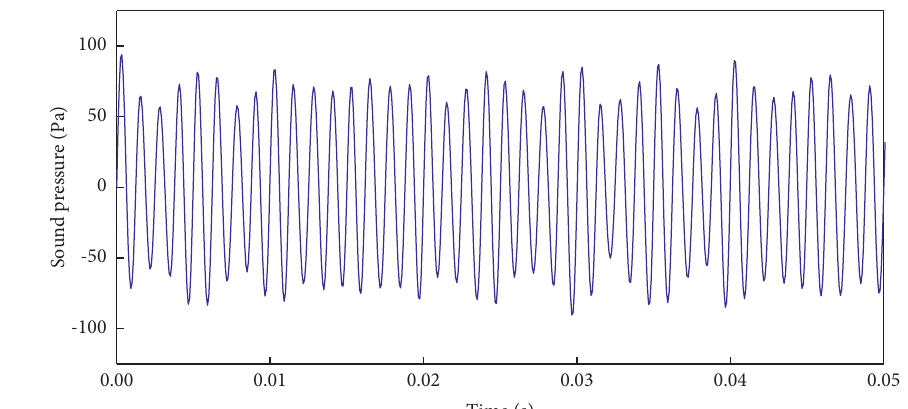
Figure 12: Sound pressure with Helmholtz resonator.